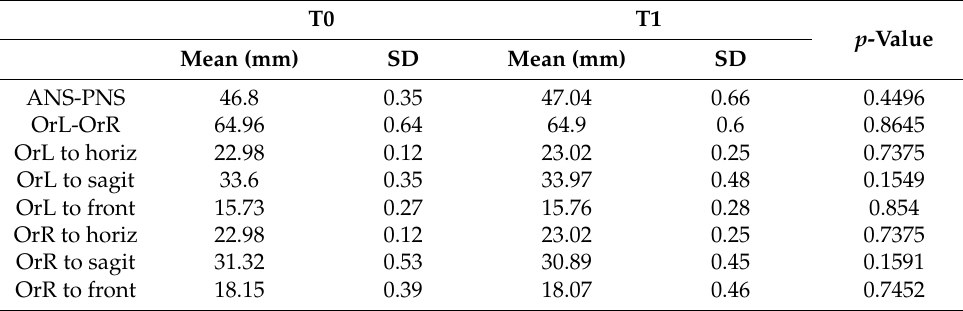
Table 3. The linear dimensions of basic maxillary landmarks at T0 and